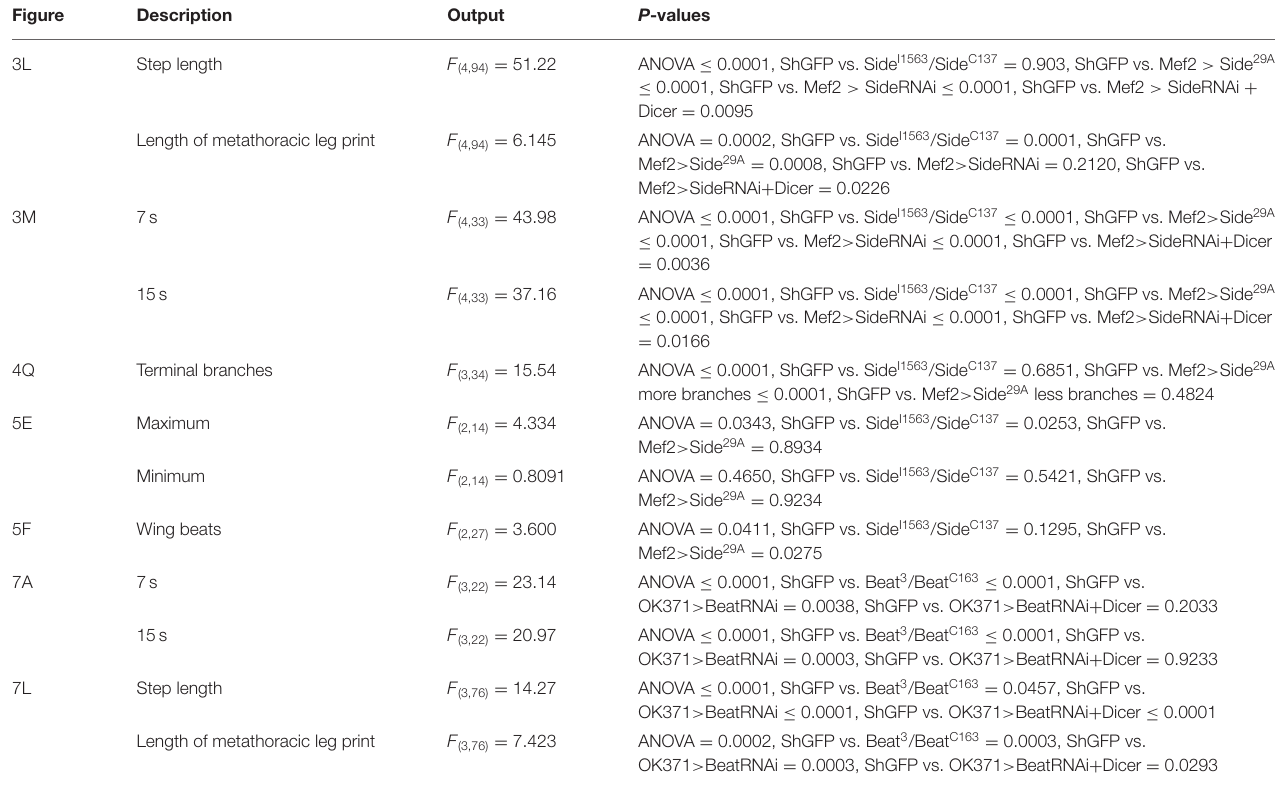
TABLE 2 | Statistical summary of one-way ANOVA with associated Dunnet’s post-hoc test. Figure